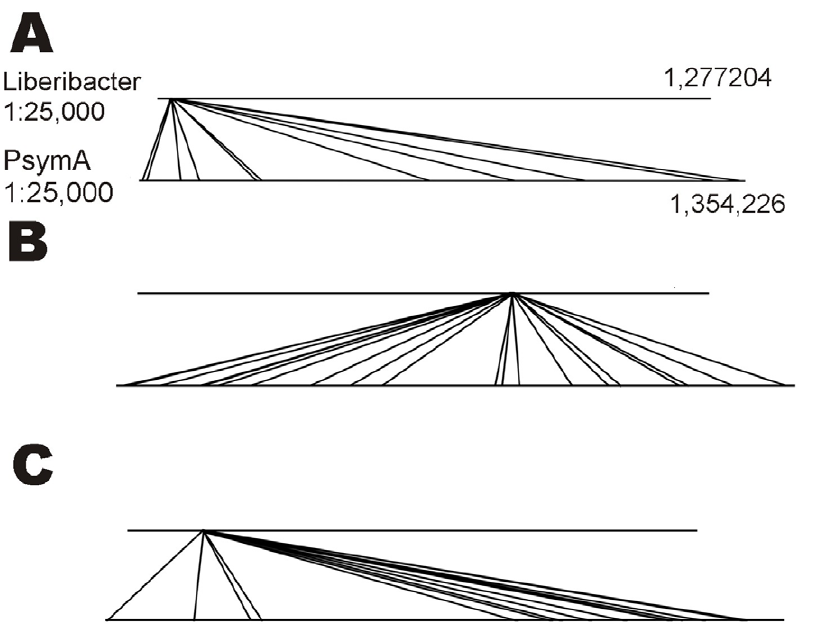
Figure 1. Distribution of genes on the S. meliloti pSymA megaplasmid that encode proteins orthologous to YP_003064586, annotated as an ABC-Type amino acid transporter in ‘ Ca . Liberibacter asiaticus’ (A), that encode proteins orthologous to YP_003064948, annotated as a 3-ketoacyl-(acyl carrier protein) reductase in ‘ Ca . Liberibacter asiaticus’ (B) and that encode proteins orthologous to YP_003064695, annotated as a LysR type regulator of transcription in ‘ Ca . Liberibacter asiaticus’